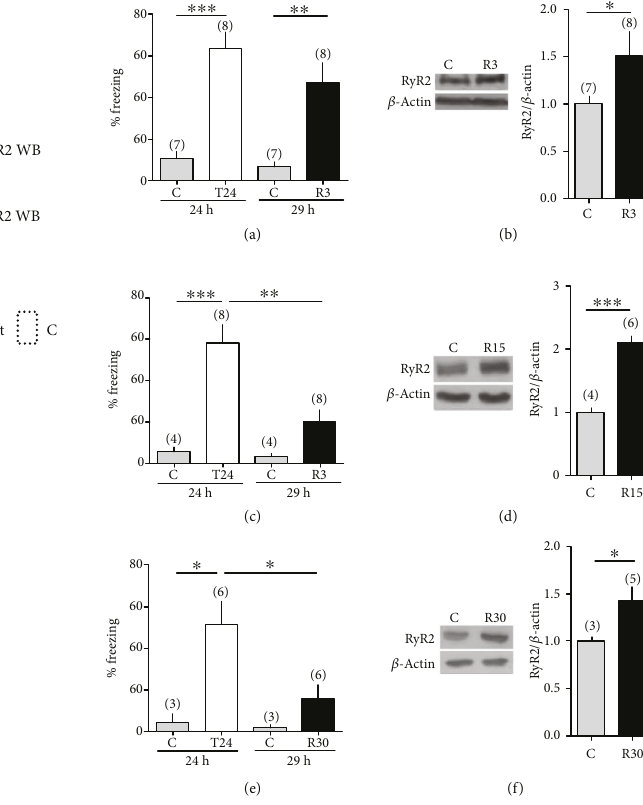
Figure 3: Context reexposure for 3, 15, or 30 min induces memory extinction and enhances RyR2 expression. (a, c, and e) Memory retention was evaluated 24h after training (T24) or 5 h after reexposure to the context for 3 min (R3), 15 min (R15), or 30 min (R30). Control rats did not receive electrical stimulation during the training session and were evaluated 5h after reexposure to the context for 3min, 15 min, or 30min. (b, d, and f) RyR2 expression was analyzed 5h after performing the respective reexposure sessions (see scheme at left). Representative blots and quanti fi cation (bar graphs) showing hippocampal RyR2 protein content in each group of rats. Values represent mean ± SE. The number of independent determinations is indicated in each graph. Statistical analysis in (a, c, and e) was done with one-way ANOVA followed by Tukey ’ s multiple comparison post hoc test; statistical analysis in (b, d, and f) was performed